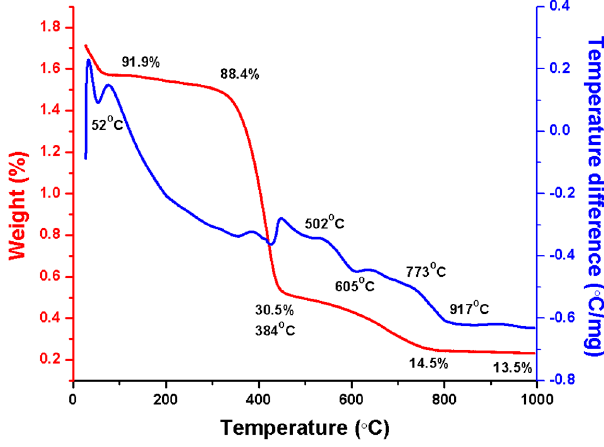
Figure 2. The thermogram of the LiNbO 3 /SiO 2 coaxial fibers.